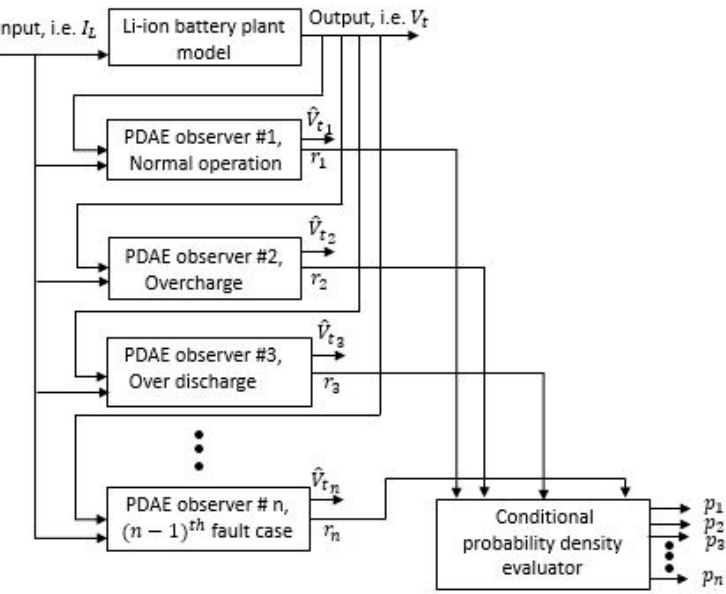
Figure 2. Multiple model adaptive estimation (MMAE) algorithm skeleton.